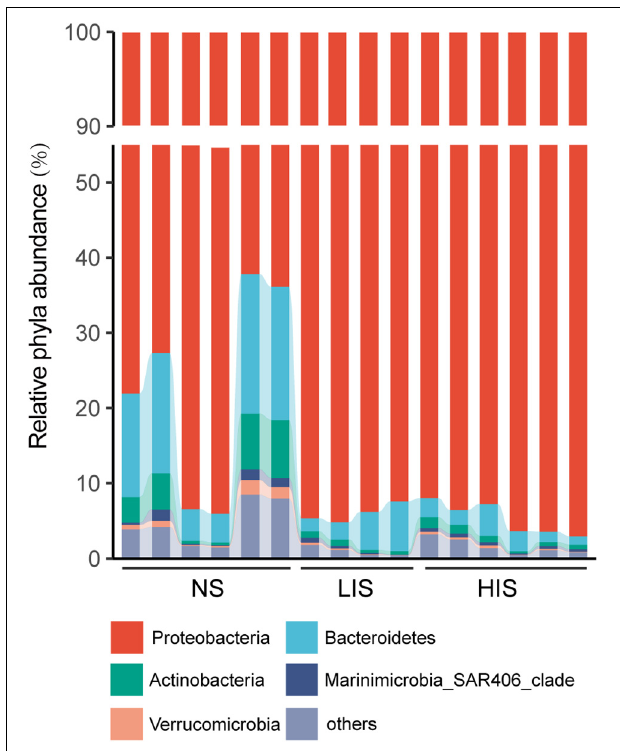
FIGURE 2 | Bar chart of the relative abundances of phylum-level taxa in 16 samples from the three study sites. To clearly show all the phylum compositions, the percentage of dominant Proteobacteria was reduced by 45% in every